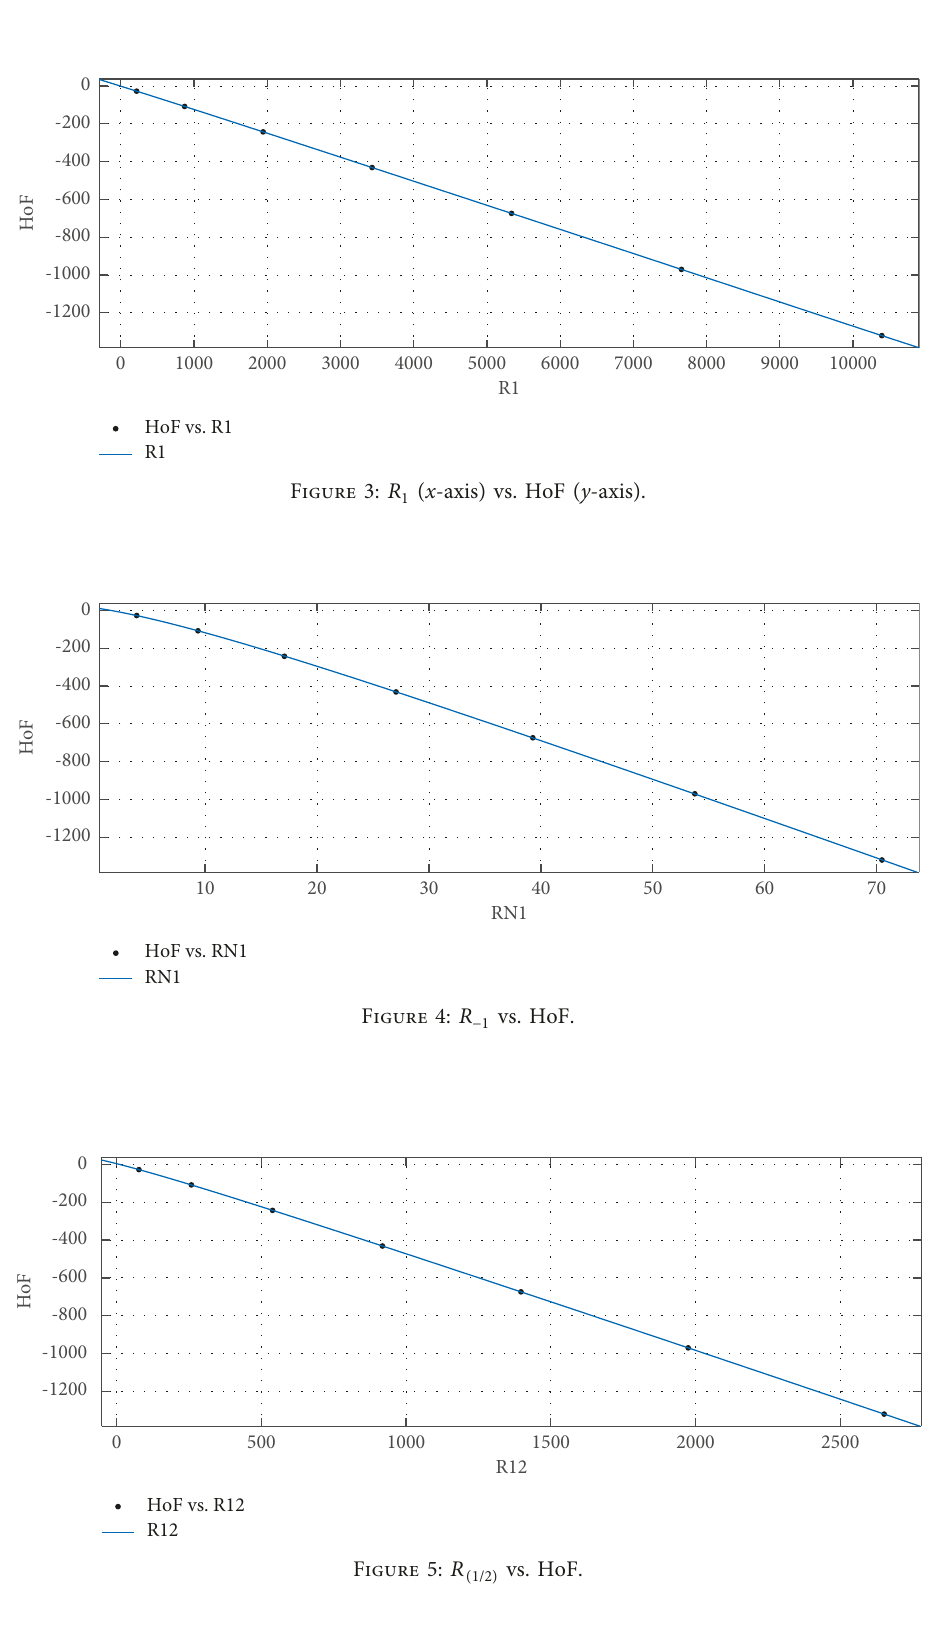
Graphical illustration for each index corresponding to l � m � i ; i � 1 , 2 , . . . , 100, computed above, is provided in Figure 2. □